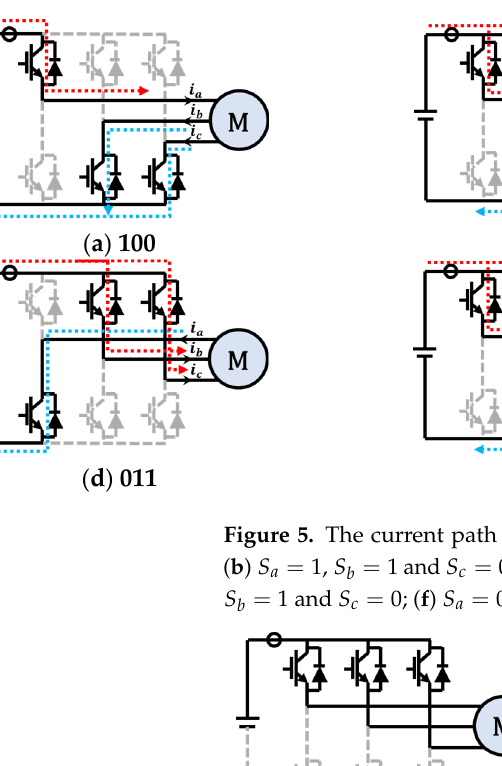
9 of 27 Figure 4. Voltage reference vector in different regions and the output current.